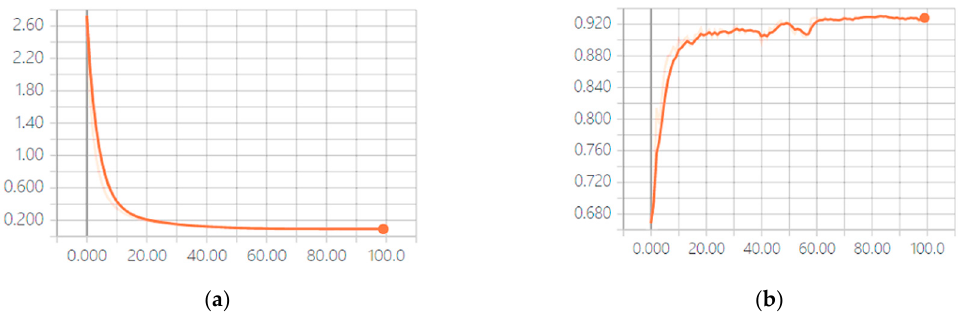
Figure 9. Training and test curve on SBU dataset: ( a ) training loss curve; ( b ) test accuracy curve.